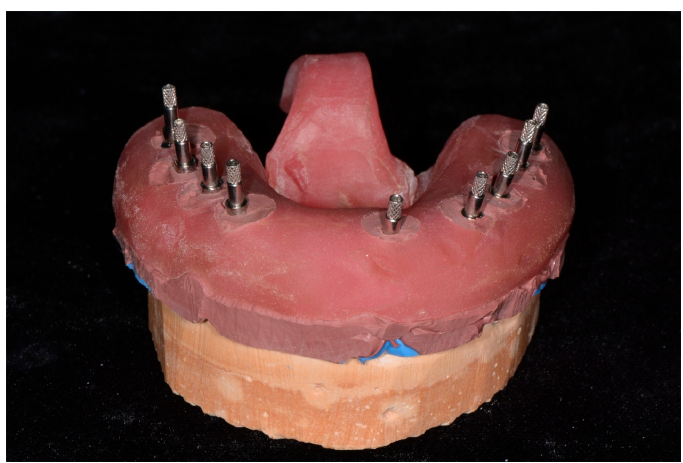
Figure 4. Creation of a stone model using implant analogs attached to copings.